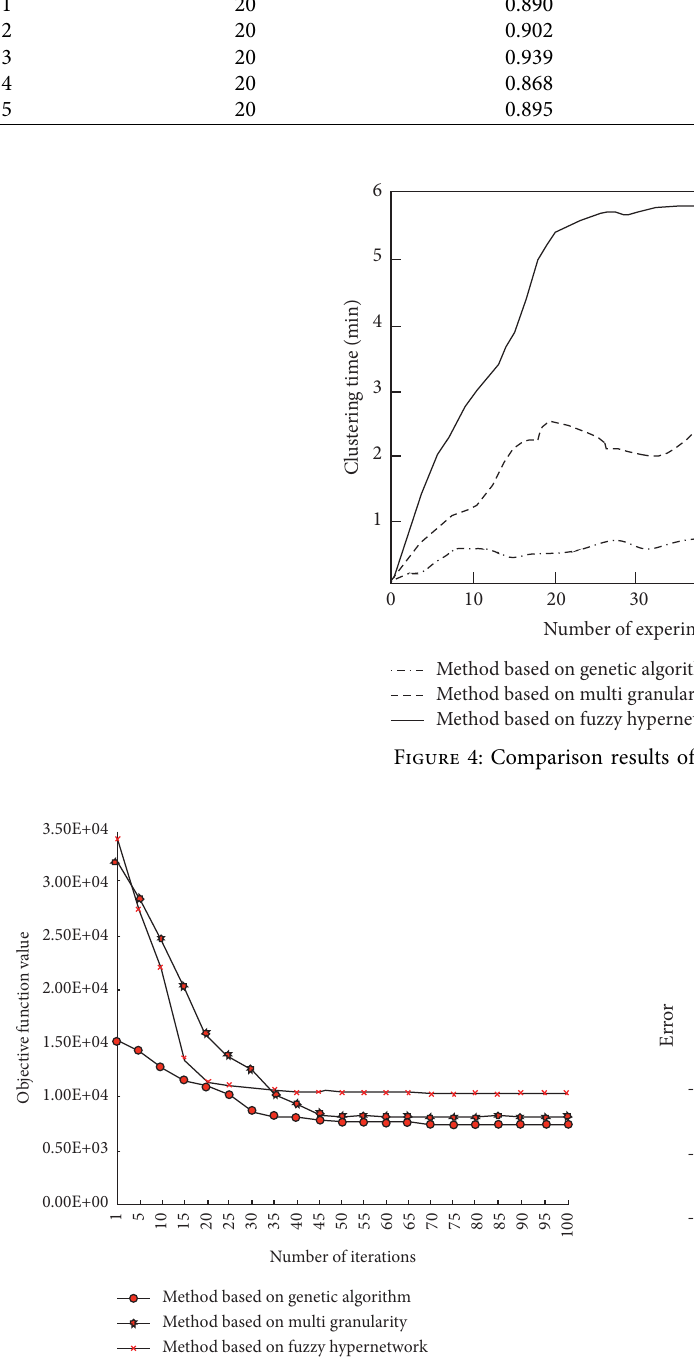
Figure 6: Comparison results of text knowledge acquisition errors.